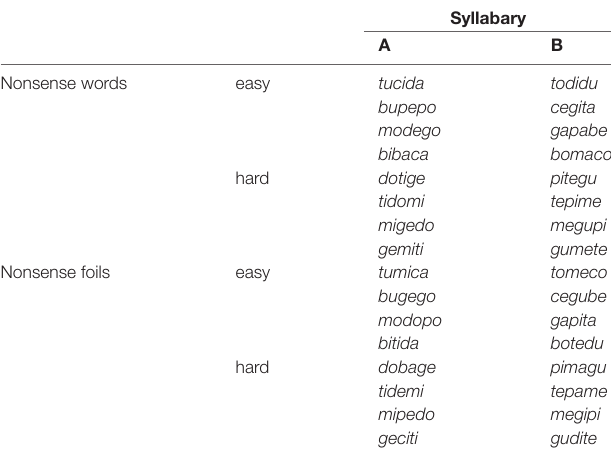
TABLE 1 | Three-syllable nonsense words and three-syllable nonsense foils from Syllabary A and Syllabary